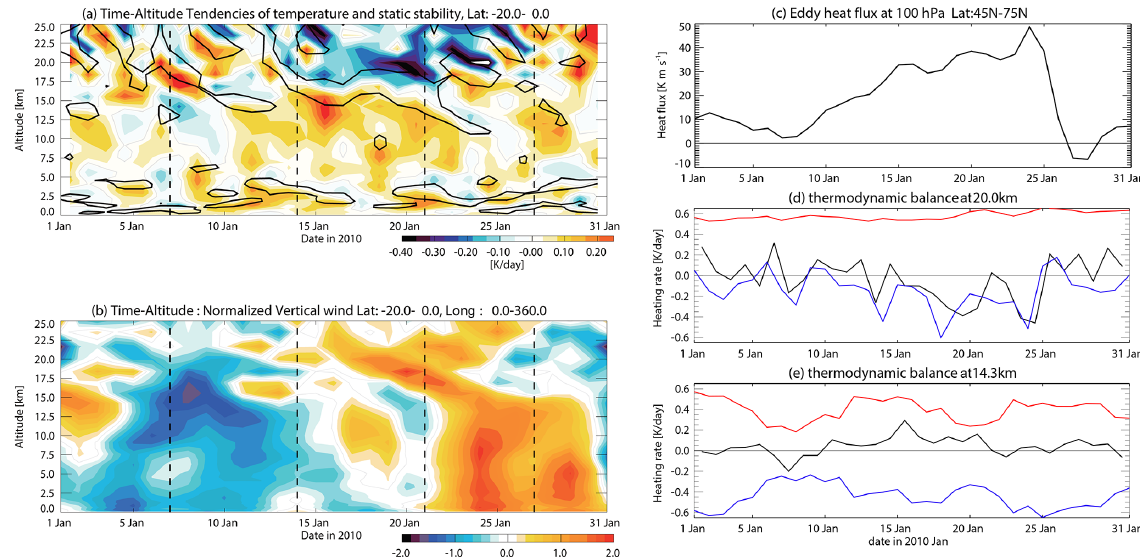
Figure 4. Time–altitude section of (a) temperature tendency (Kday − 1 ) (colour shading) and tendency of static stability with value of − 0.02 (10 − 4 s − 2 day − 1 ) shown by black contours and (b) anomalous normalized vertical velocity averaged between 20 ◦ S and equator from 1 to 31 January 2010. The normalized values are obtained by dividing them by the standard deviation at each altitude. (c) Time series of zonal mean eddy heat flux (Kms − 1 ) at 100hPa averaged between 45 ◦ N and 75 ◦ N. Panels (d, e) show the time series of thermodynamic balance at 14.3 and 20.0km averaged between 20 ◦ S and Equator. The black, red and blue lines indicate temperature tendency ( ∂T/∂t ), diabatic heating rate due to cloud microphysics and radiation, and adiabatic heating rate due to residual vertical velocity ( − N 2 ω ∗ ),